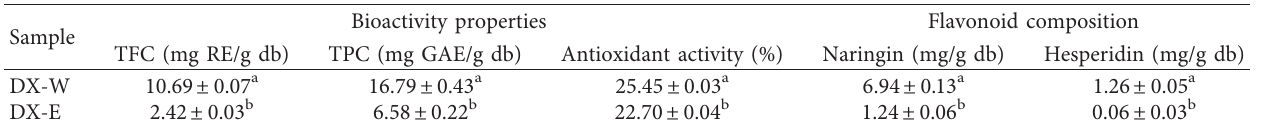
Table 6: Bioactivity properties and flavonoid composition of extracts from different extraction methods 1,2 .